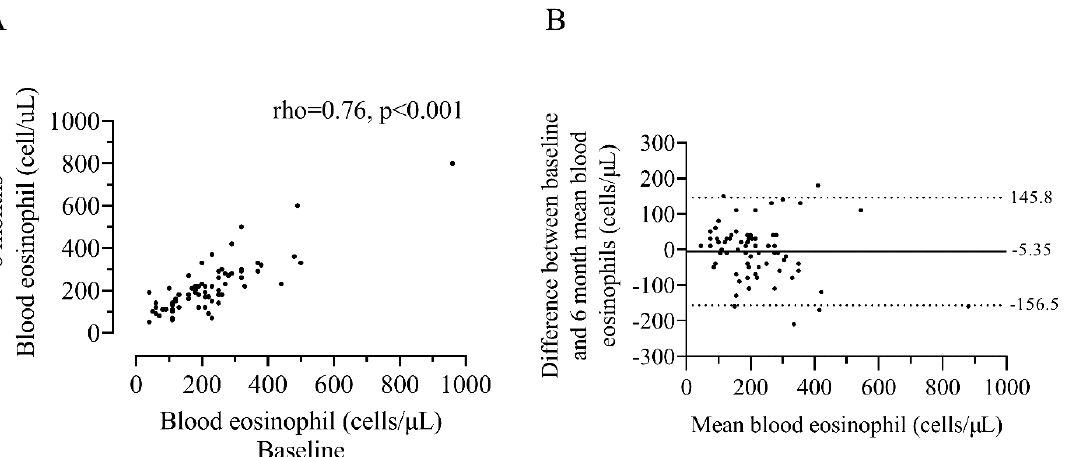
Figure 4. Association between baseline and 6 month measurements of blood eosinophil counts ( A ) and a Bland–Altman plot of the difference versus the mean of two repeat measurements ( B ). Horizontal solid black line in panel B represents the mean difference and horizontal dotted black lines represent the upper and lower 95% limits of agreement. n = 71.